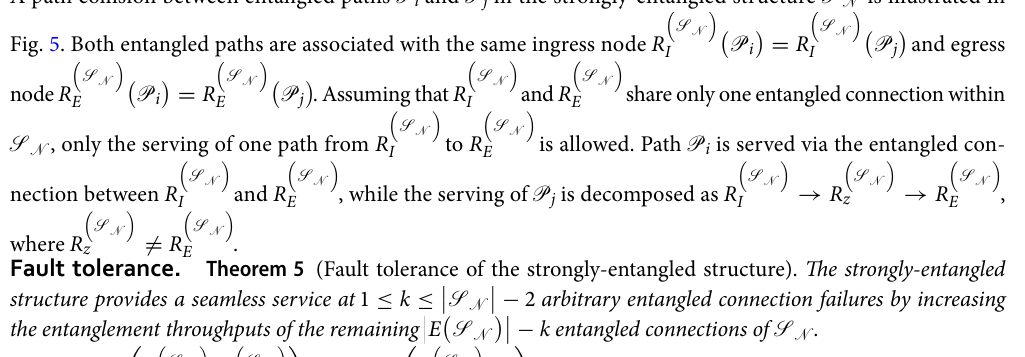
Fig. 5. Both entangled paths are associated with the same ingress node R (cid:31)